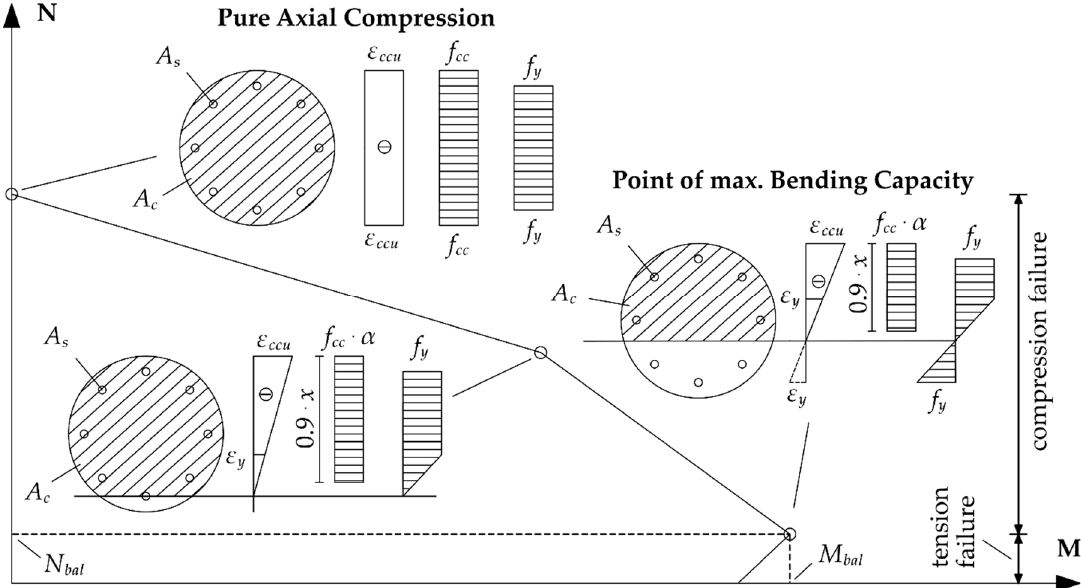
Figure 2. Design procedure for a fiber reinforced polymer (FRP) confined reinforced concrete (RC) column subjected to combined compression and bending.